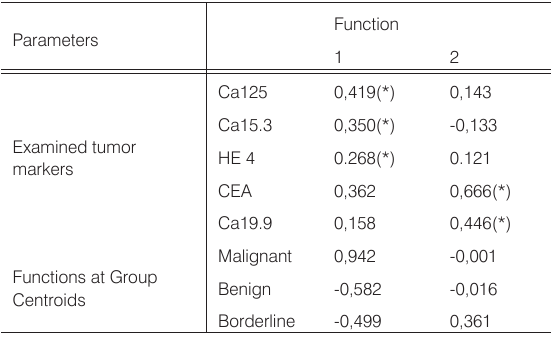
and standardized canonical discriminant function and group centroids of discriminant function